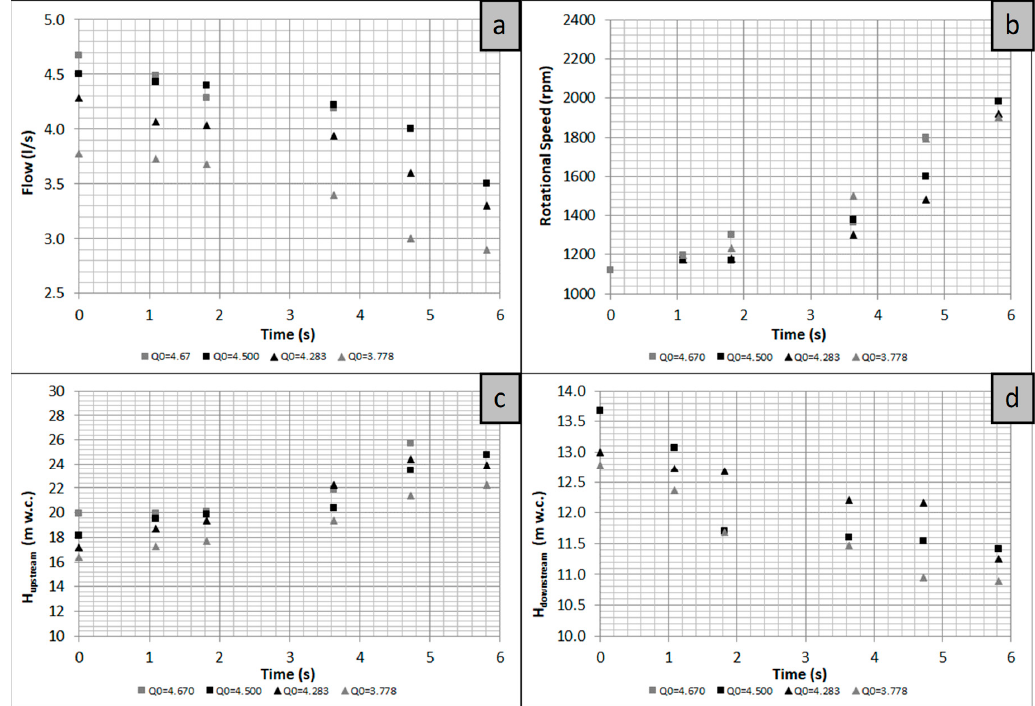
Figure 13. Experimental data of flow, rotational speed, and upstream and downstream head in the radial machine under the overspeed effect. ( a ) flow for radial machine ( b ) rotational speed for radial machine ( c ) flow for axial machine ( d ) rotational speed for axial machine.